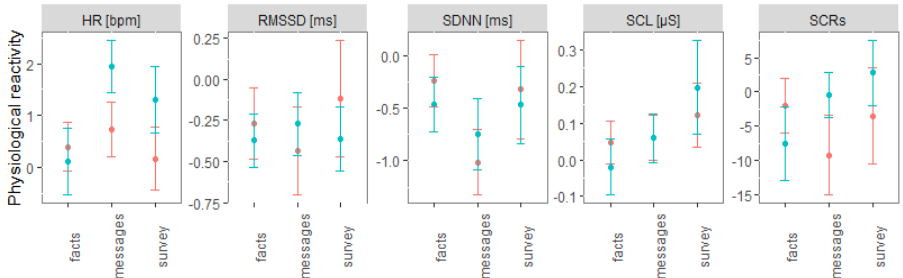
Figure 2. Average physiological reactivity per segment for each experimental group with error bars representing standard errors of the mean. Red = group that received HCL, blue = group that received LCL.